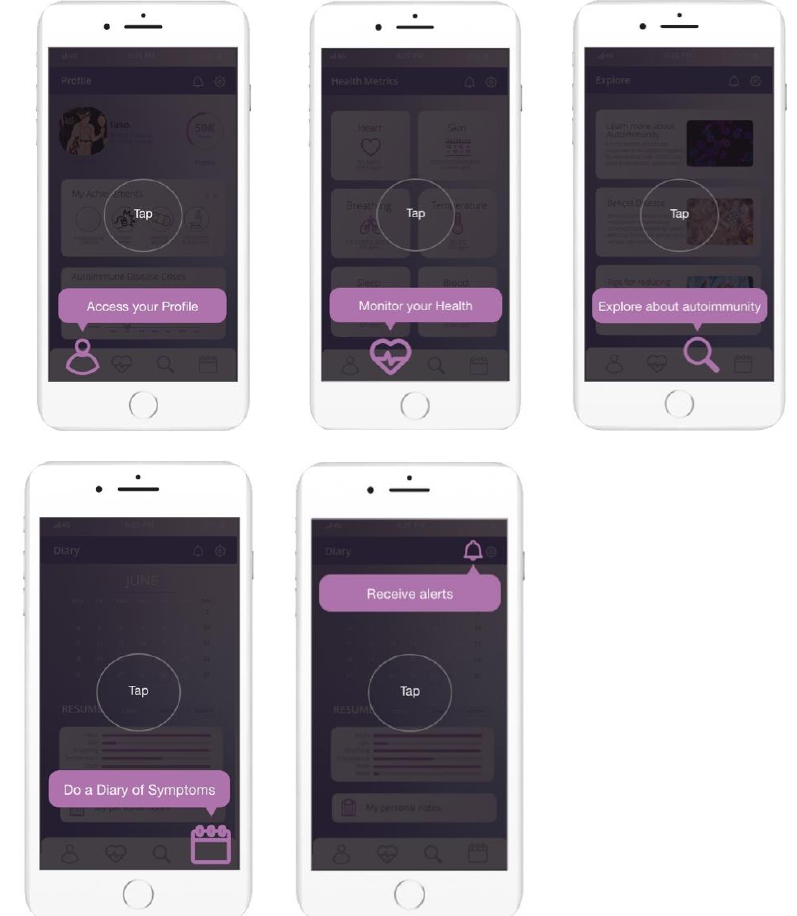
Figure 4. Smartphone app iShU tutorial with main functionalities (from left to right and up to bottom ).